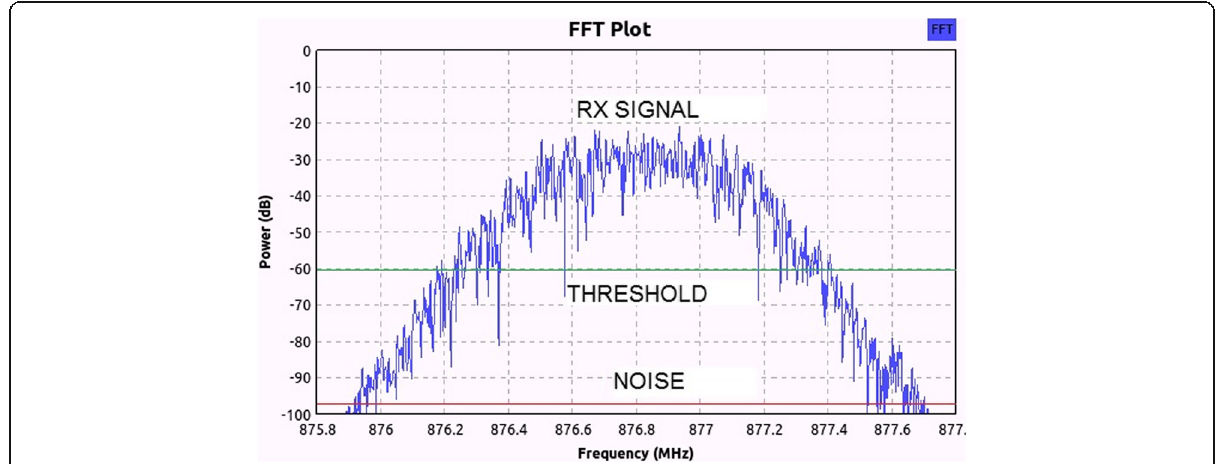
Fig. 4 Energy detection threshold for PU or